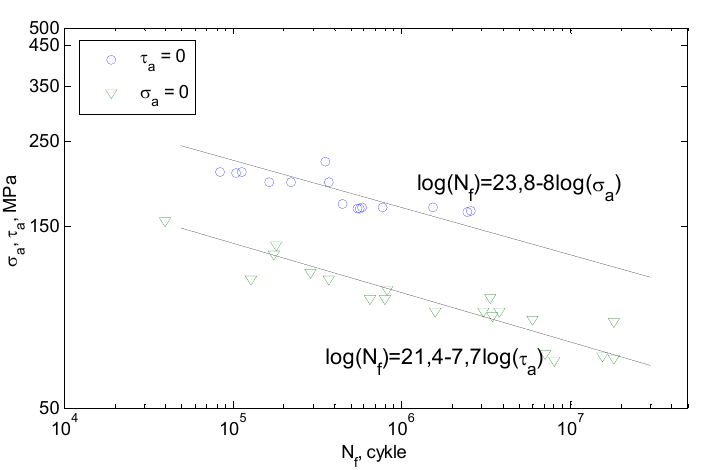
Figure 1: Fatigue diagram for oscillatory bending and bilateral torsion for the 6082-T6 aluminum alloy (where  a ,  a are stress amplitudes generated by torsional moment and bending moment, respectively).